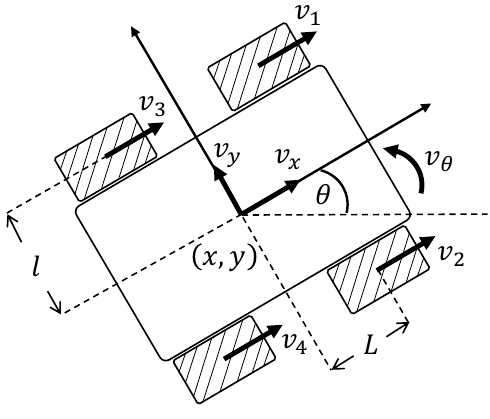
Figure 7. Schematic of an omnidirectional mobile robot conformed of four mecanum wheels. See Figure 18 for a real mobile